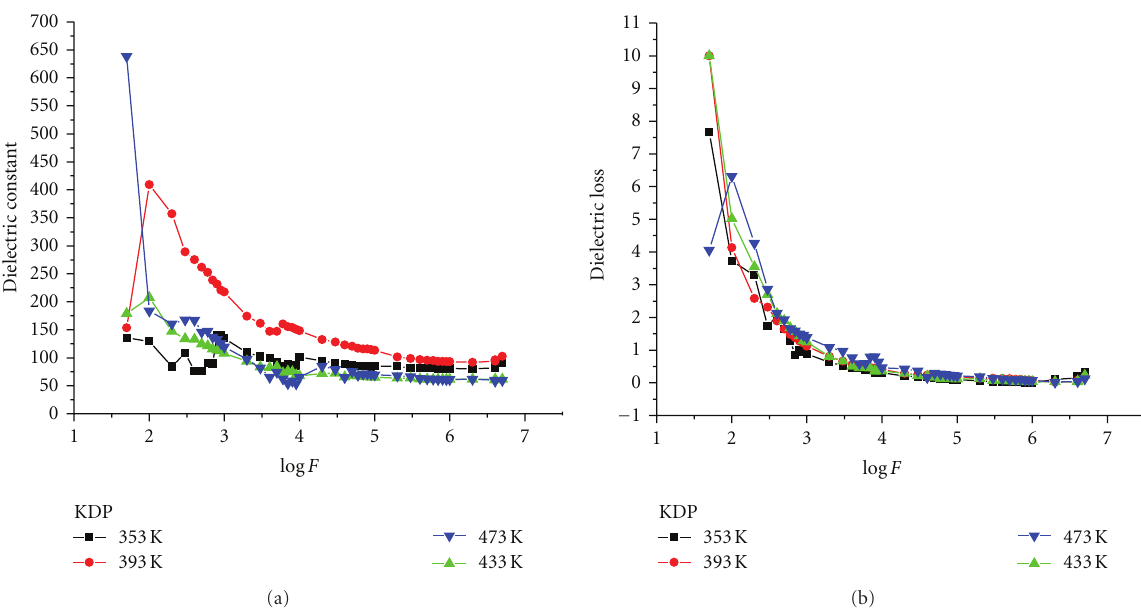
Figure 2: (a) Variation of dielectric constant with frequency for all temperatures (pure KDP). (b) Variation of dielectric loss with frequency for all temperatures (lysine-doped KDP).